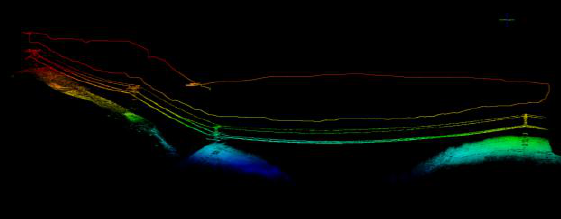
Figure 3. Jinsu transmission line No.80-83 tower flight path